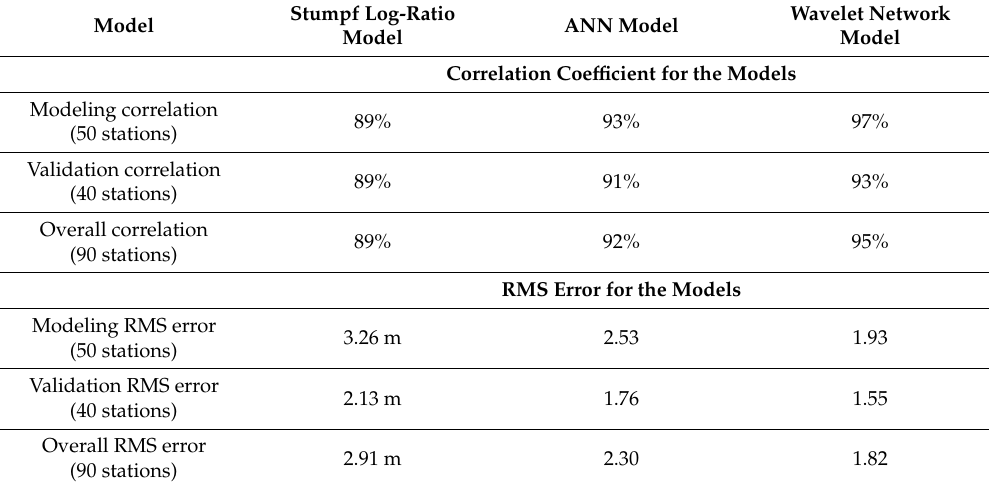
Table 1. The correlation and RMS error for traditional Stumpf log-ratio, ANN, and wavelet network models.